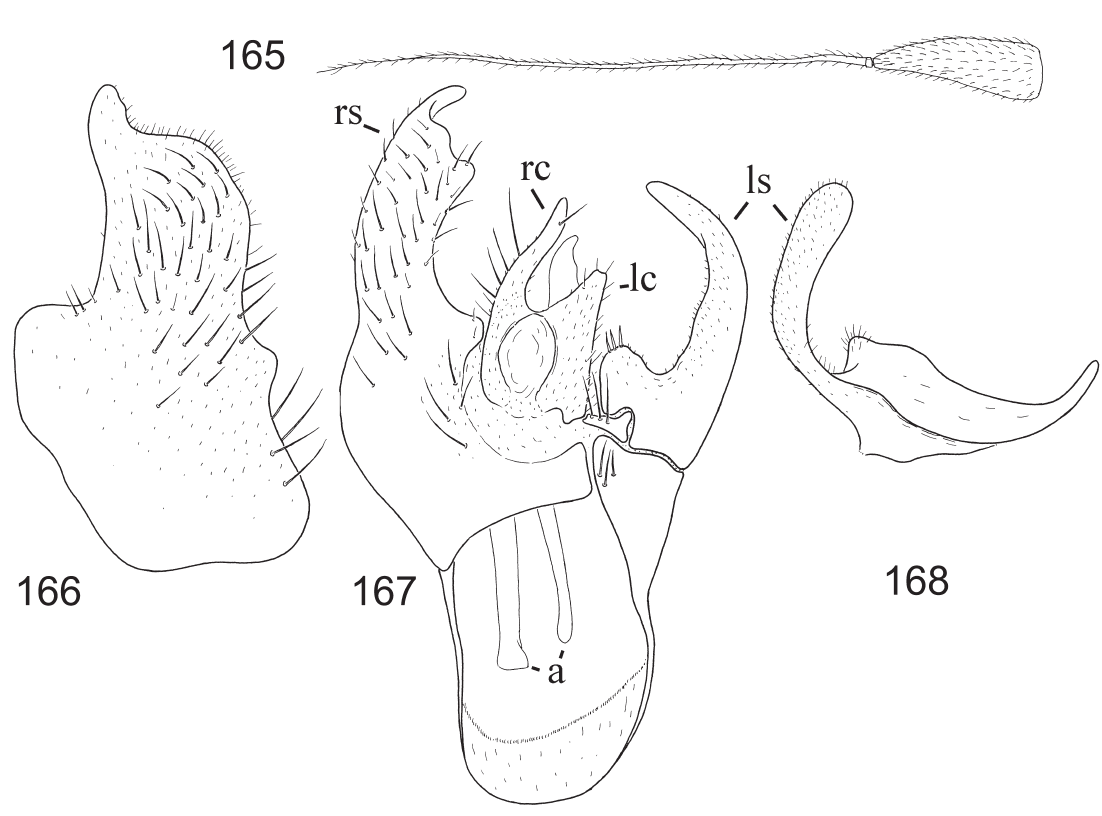
Figs 165-168. Elaphropeza kranjiensis sp. nov., ♂. 165 . postpedicel and stylus of antenna, lateral view. 166 . right epandrial lamella, lateral view. 167 . epandrium with cerci, dorsal view. 168 . left surstylus, lateral